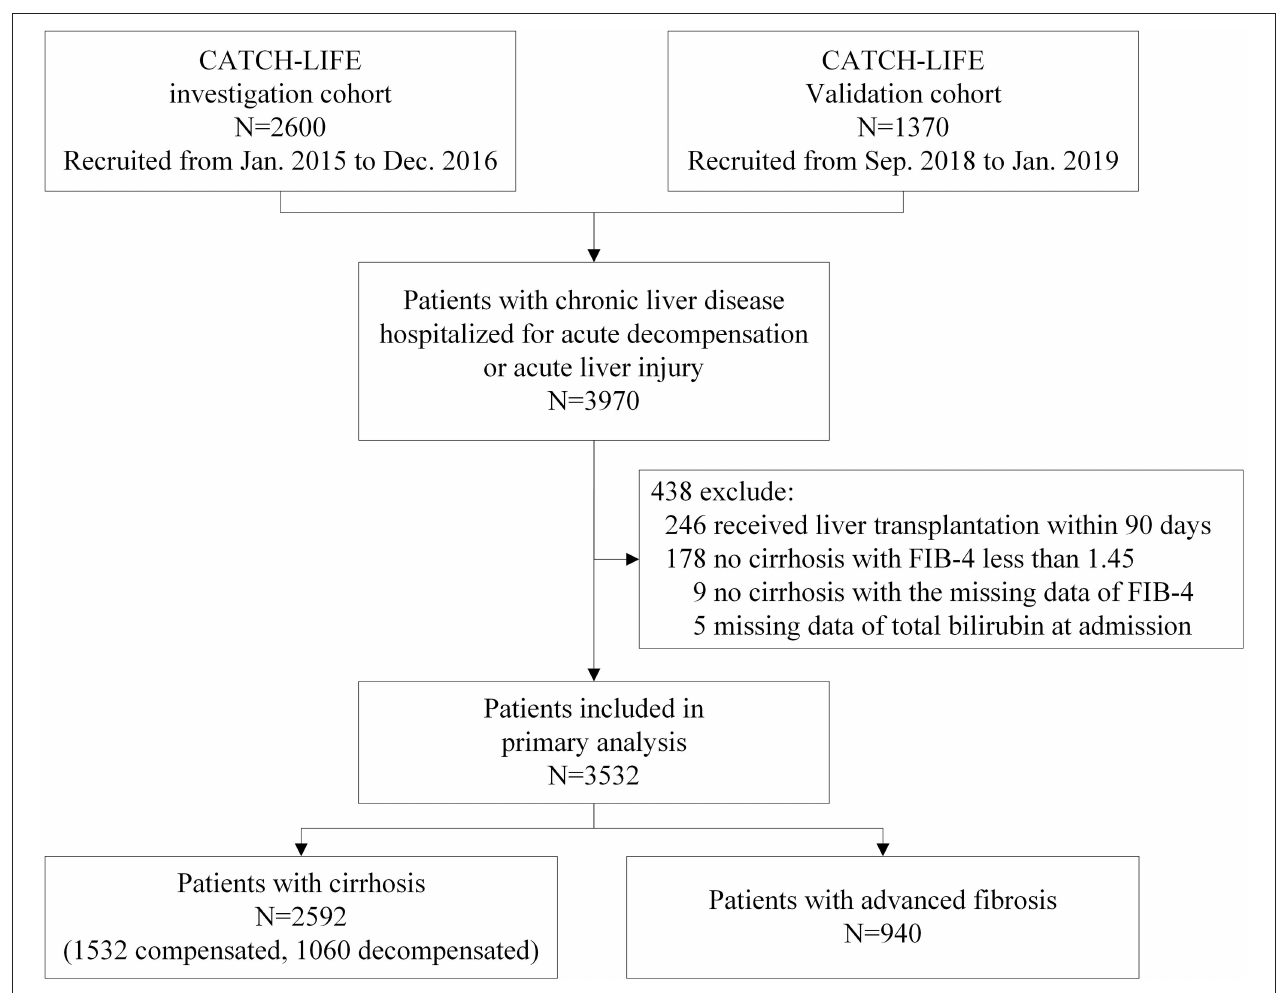
FIGURE 1 | Flowchart of the study.